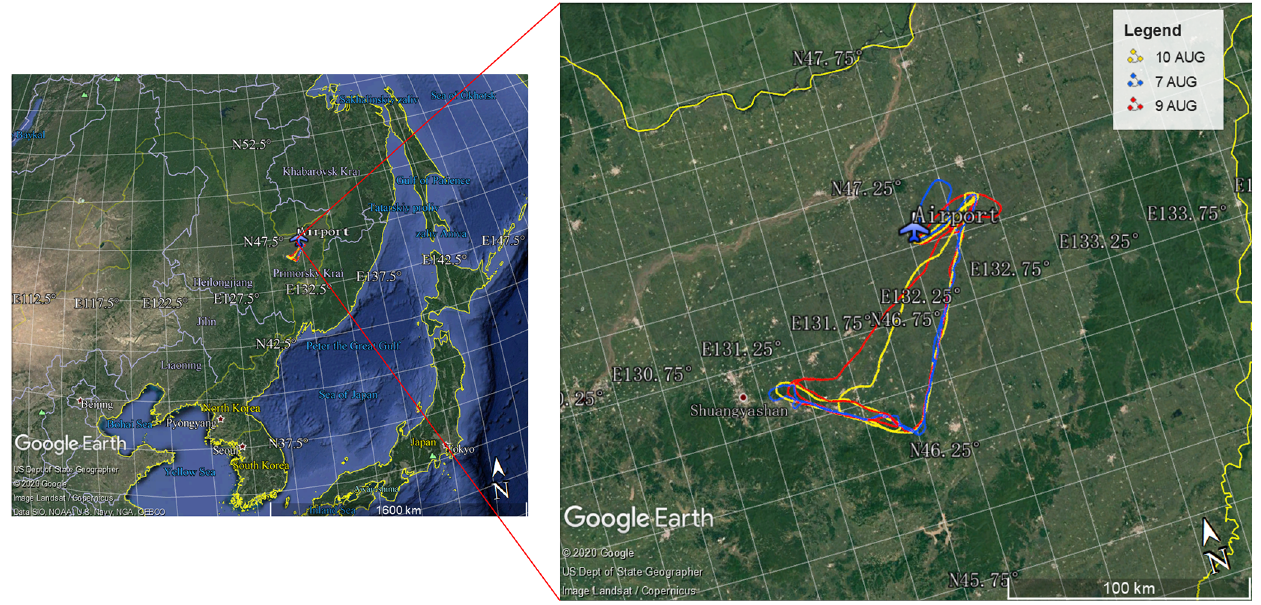
Figure 3. Observation area for aircraft-based measurement of CO 2 and CH 4 over Jiansanjiang, northeast China, and the flight paths on 7, 9 10 August.